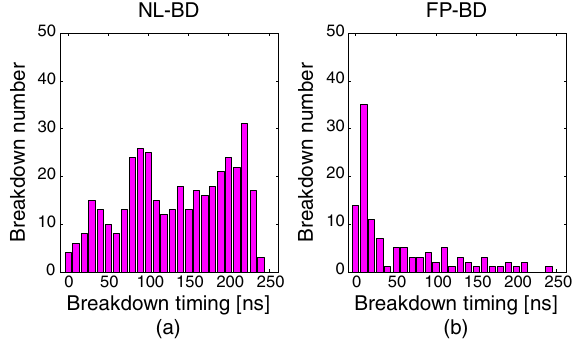
FIG. 19. Breakdown timing distribution of TD24R05_#2.